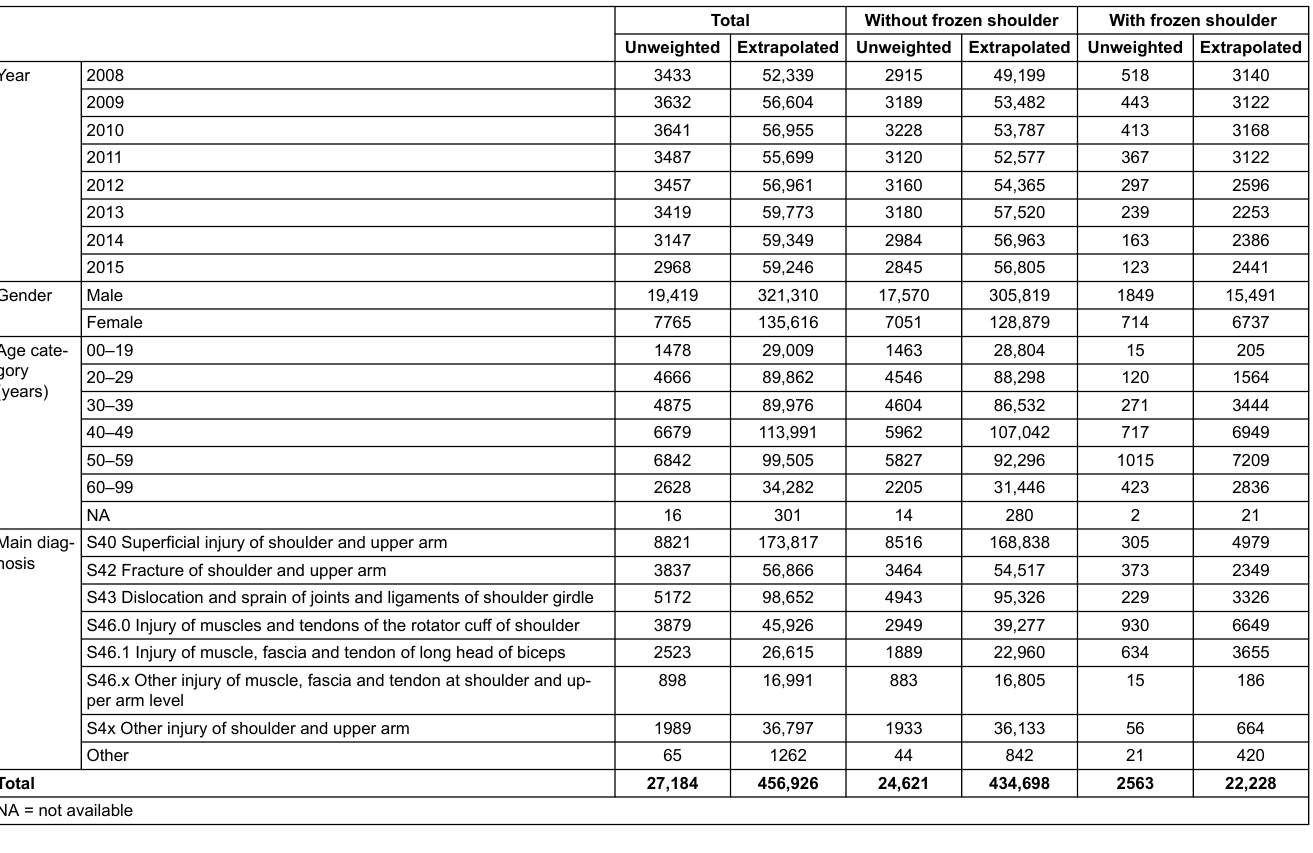
Table 1: Patient characteristics with number of observations with shoulder injuries as main diagnosis in sample database (raw cases, unweighted) and extrapolation for total in- cidences (weighted for projection).